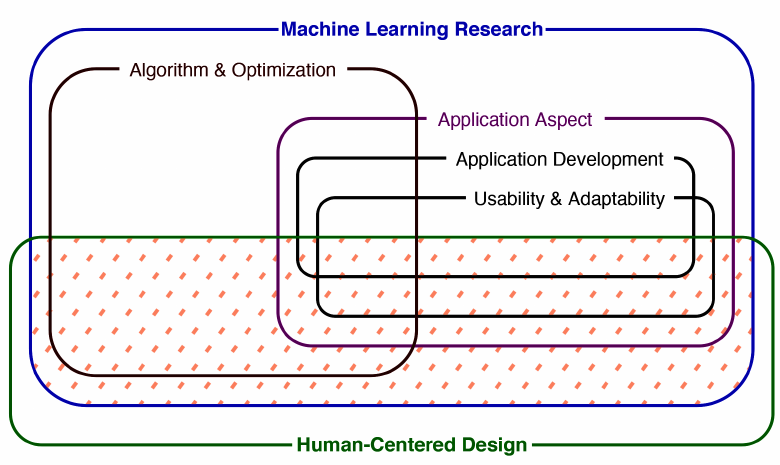
Figure 4. Human-Centered Machine Learning (marked with dashed lines) research lays over a broad spectrum, as shown here. The intersection of Machine Learning Research and Human-Centered Design is the domain we identify as Human-Centered Machine